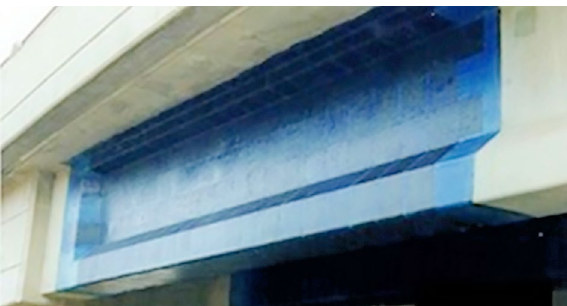
Fig. 5. Externally-bonded carbon FRP sheets for shear strengthening of a reinforced concrete bridge girder (photo from http://www.fhwa.dot.gov/everydaycounts/